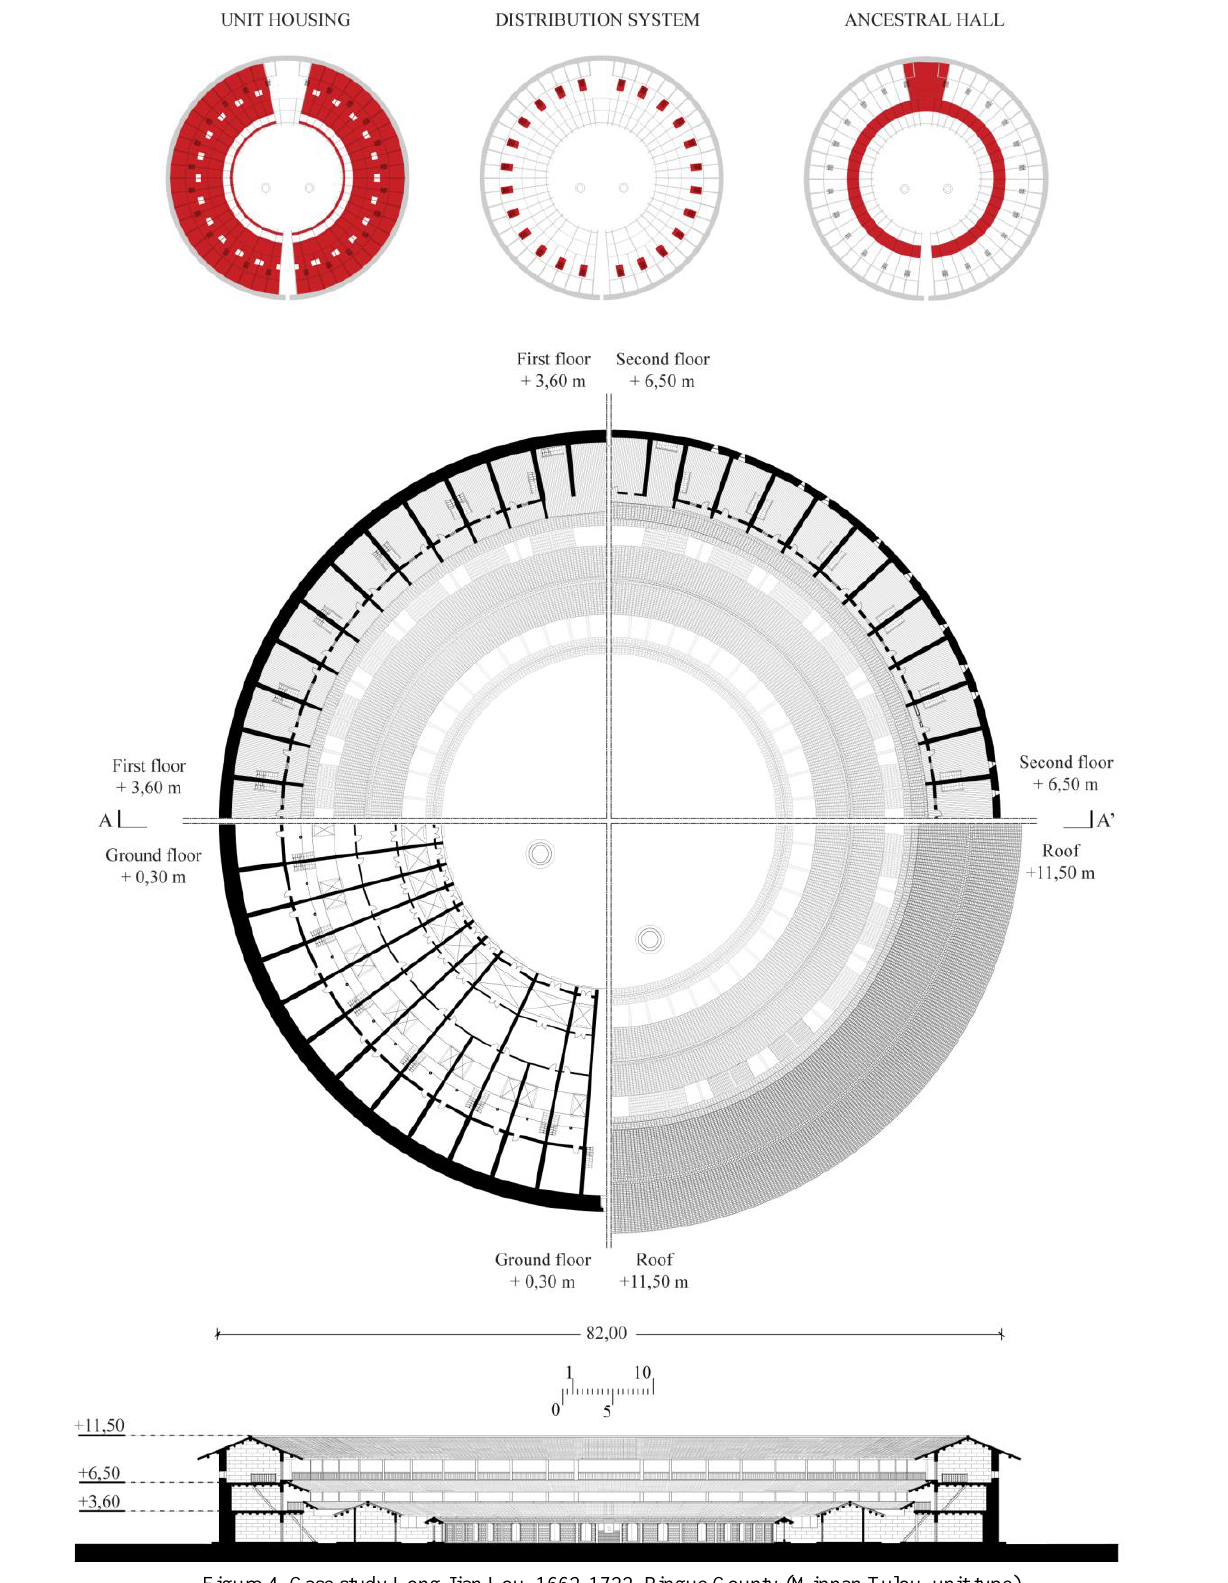
Figure 4. Case study Long Jian Lou, 1662-1722, Pingue County (Minnan Tulou, unit